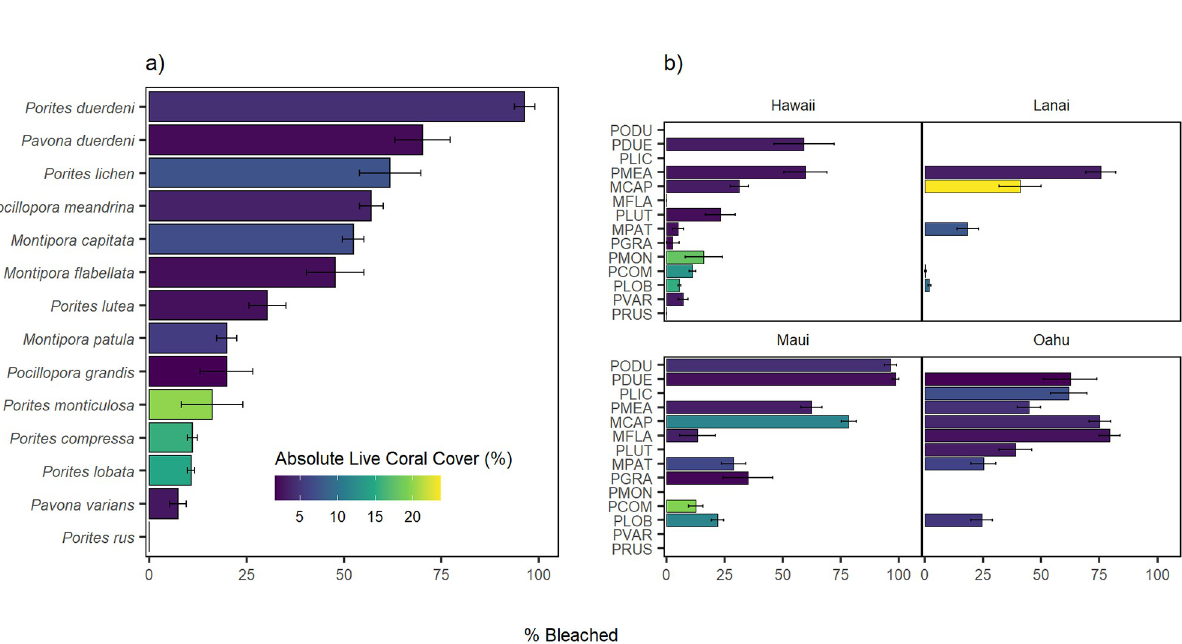
Fig 3. Species-level mean ( ± SE) percent bleached colored by absolute cover for all depths combined at the (a) domain level (MHI) and (b) island level in 2019. Gaps between bars represent taxa observed on fewer than six surveys per island.